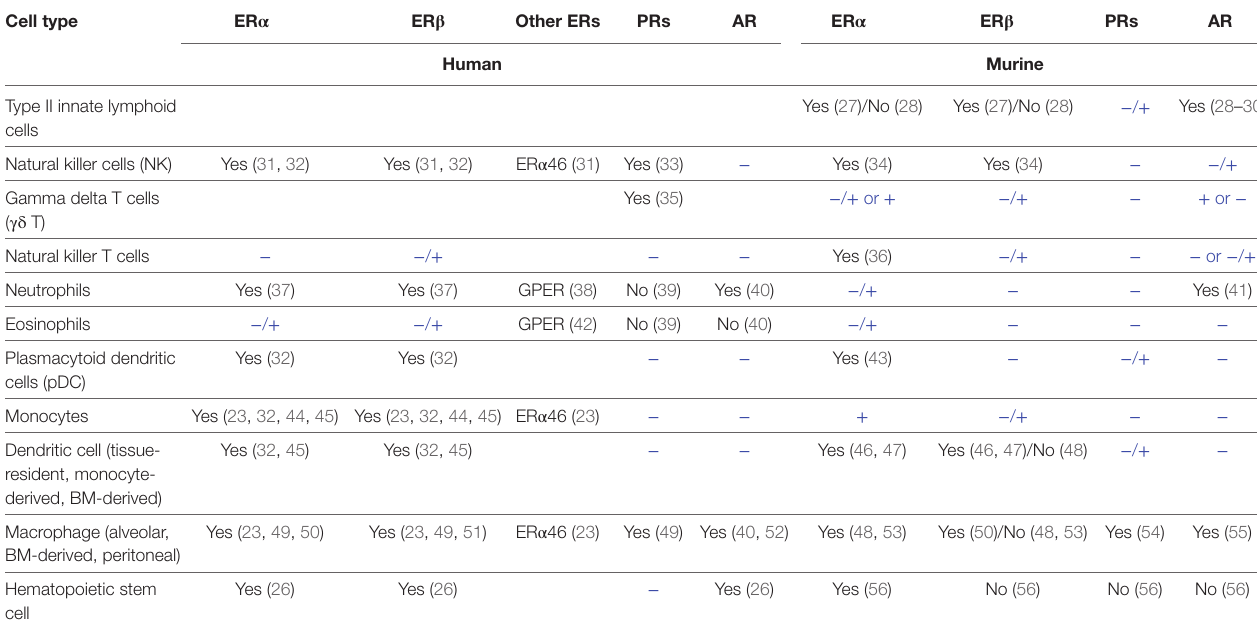
TAbLe 1 | Expression of sex steroid receptors in human and murine innate immune cells. Cell